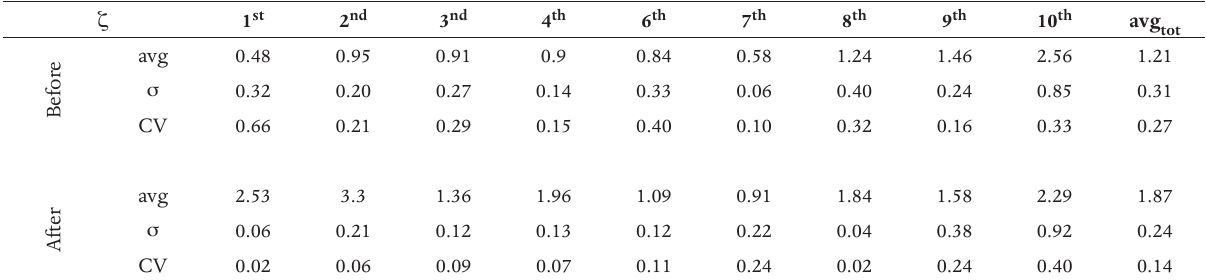
Table 3. Statistics of damping coefficients before and after strengthening for comparable vibration